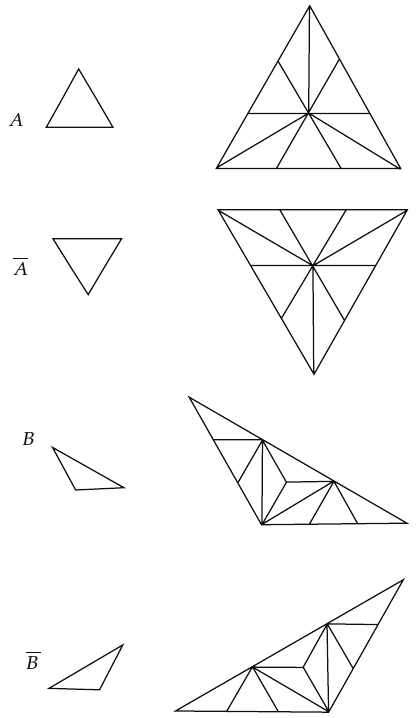
Figure 6: Inflation rules for the equithirds